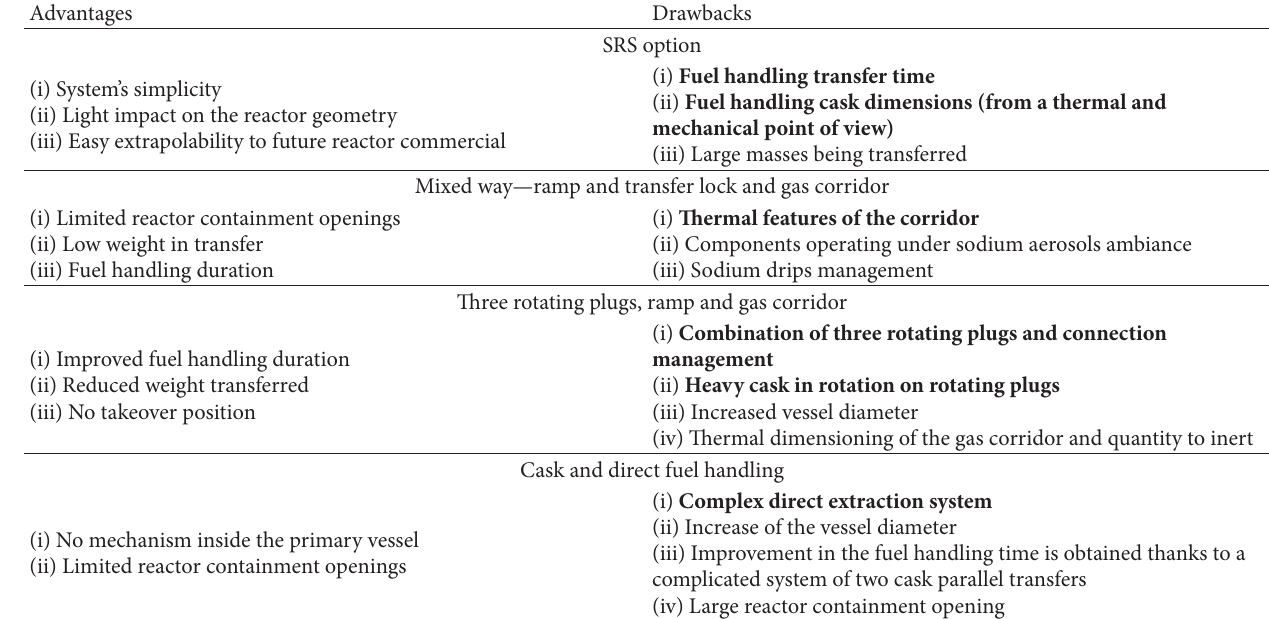
Table 1: Advantages and drawbacks of the reference solution plus the innovative solution investigated.